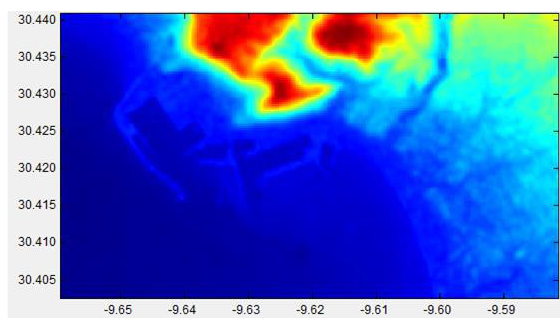
Figure6. Digital Elevation Model of Agadir bay